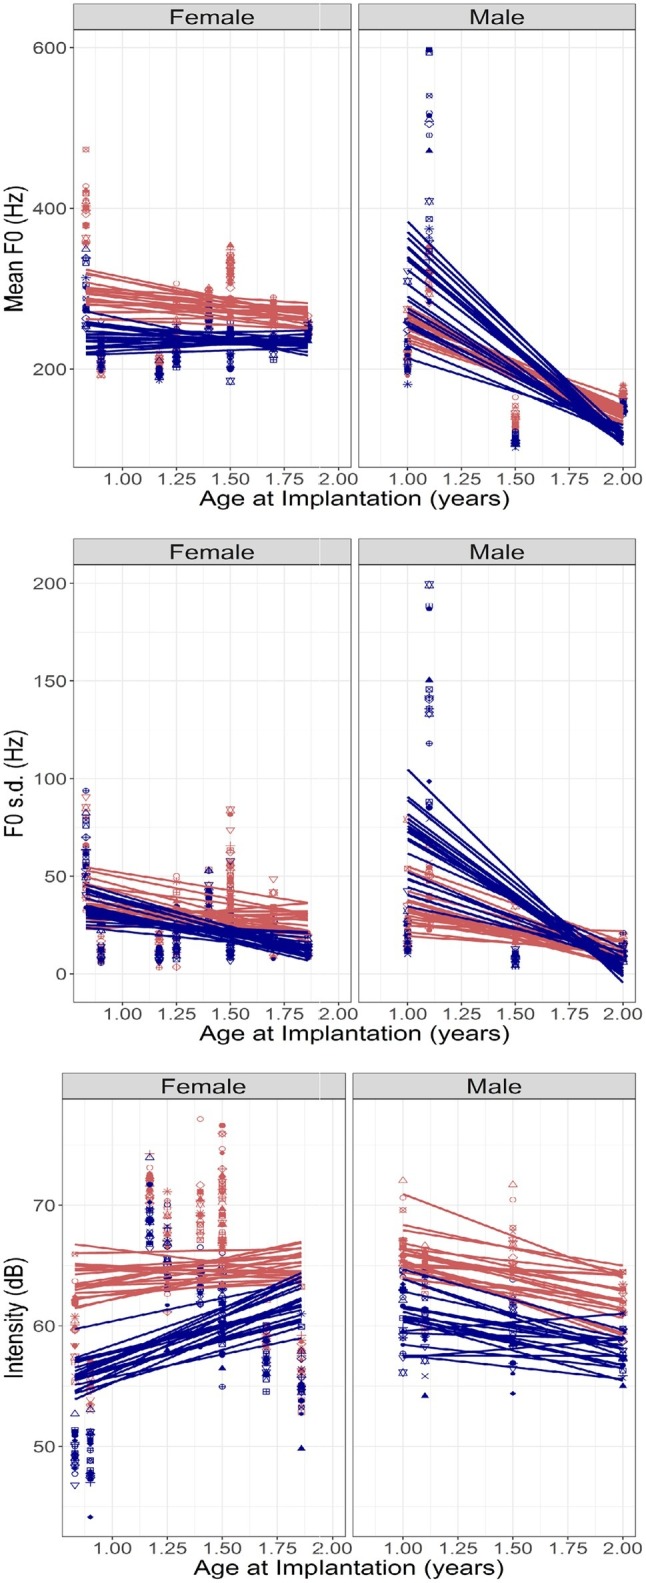
(Top to bottom) Mean F0, F0 s.d., and Intensity of productions by CCI, plotted against their age at implantation. Left- and right-hand panels show results in female and male participants, respectively. Red and blue symbols represent happy and sad emotions, respectively, and the differently shaped symbols and the lines represent individual sentences recorded in each emotion.